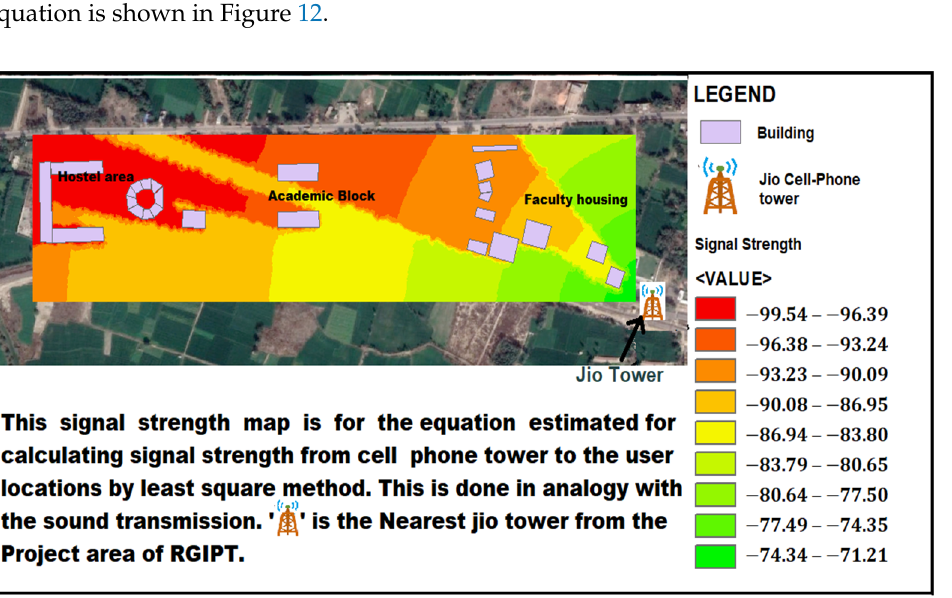
Figure 12. Signal Strength after the determination of the signal strength equation from the nearest JIO cell phone tower on the RGIPT campus.